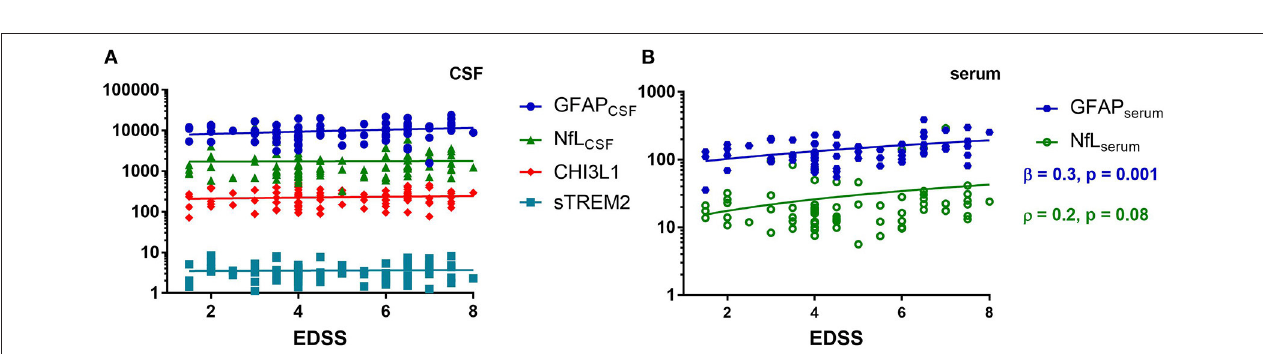
FIGURE 3 | Spearman correlation of cerebrospinal fluid (CSF) (A) and serum (B) biomarkers with the clinical severity as measured by the expanded disability status scale (EDSS). Glial fibrillary acidic protein (GFAP), neurofilaments light chain (NfL), chitinase 3 like 1 (CHI3L1), soluble triggering receptor expressed on myeloid cells 2 (sTREM2), ρ (Spearman rho), β (standardized coefficient) of multiple linear regression, age as a covariant.